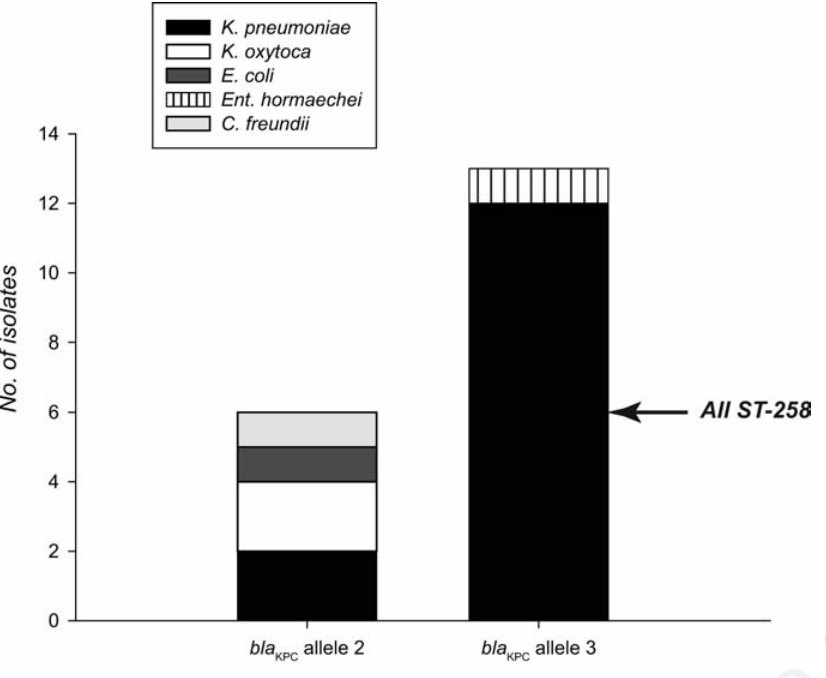
Figure 1. The number and species of CPE isolates carrying blaKPC alleles 2 or 3. All K. pnuemoniae isolates carrying allele 3 belonged to ST